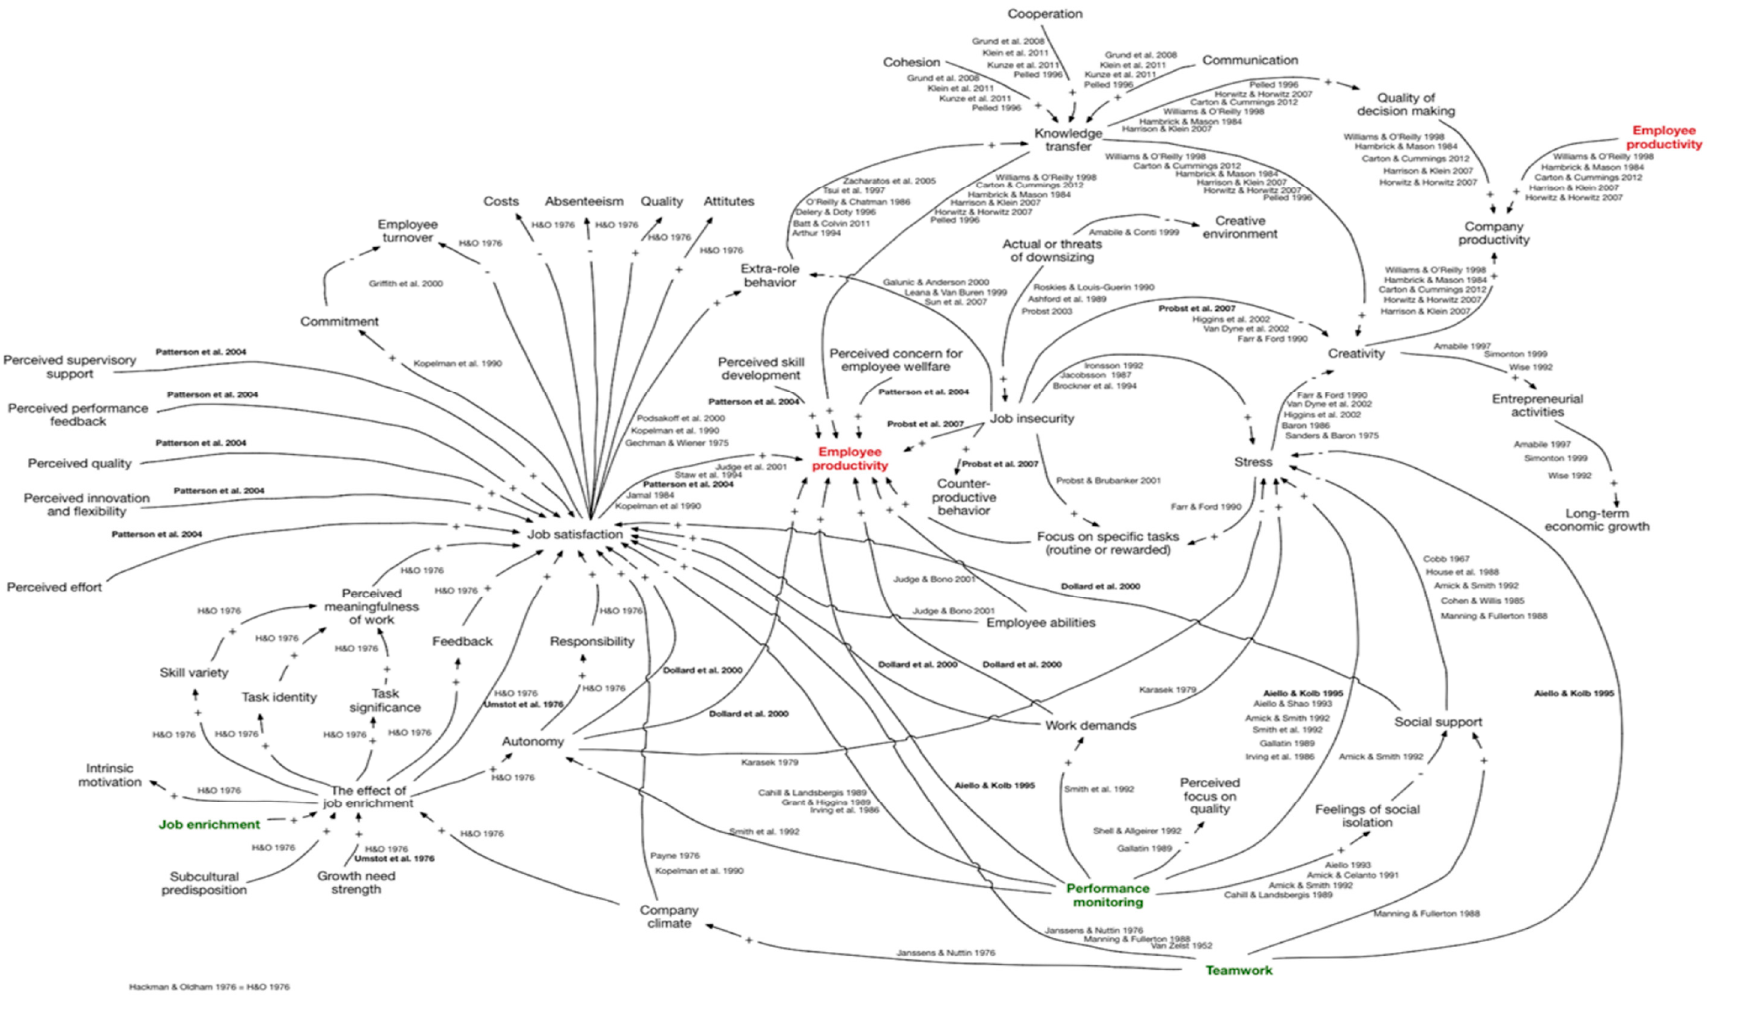
Figure 7. Wellbeing CLD from synthesis step 1.